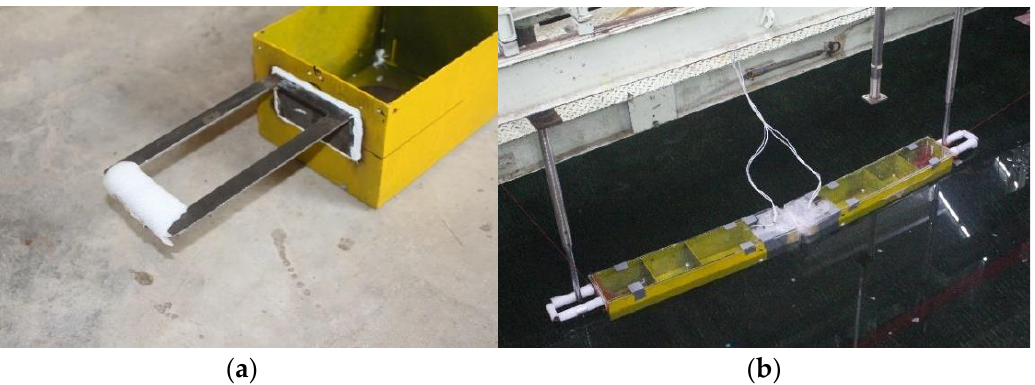
Figure 3. The mooring system and the floating body. ( a ) The navigation board. ( b ) The mooring system.